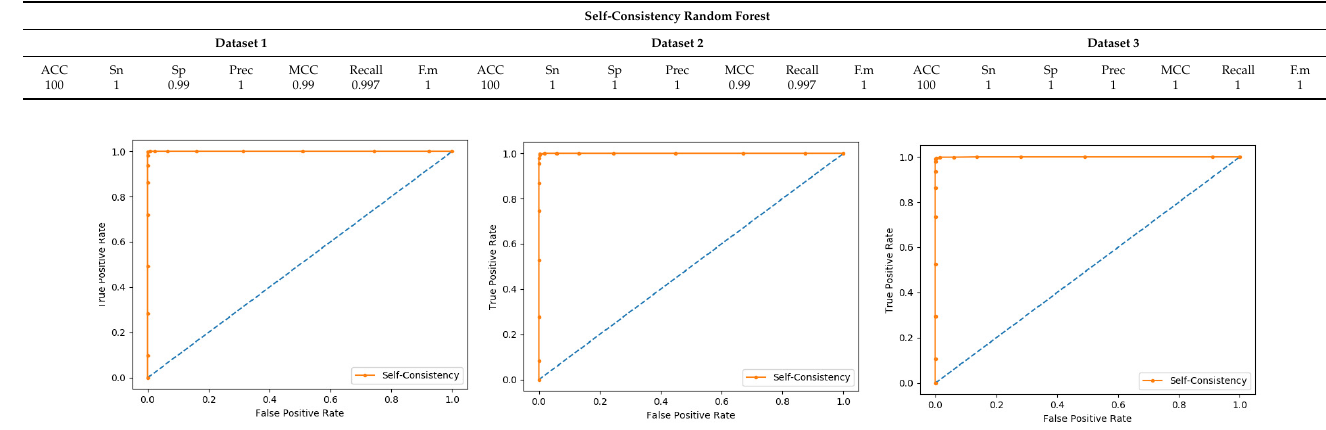
Figure 9. Jackknife PNN ROC curve. Table 6. Results of self-consistency based on Random Forest.